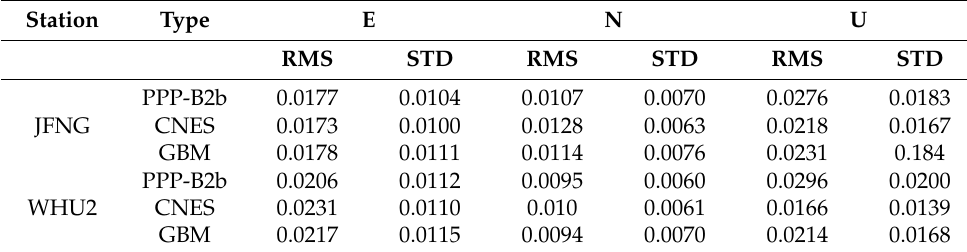
Table 3. The positioning accuracy of JFNG and WUH2 stations (unit: m).